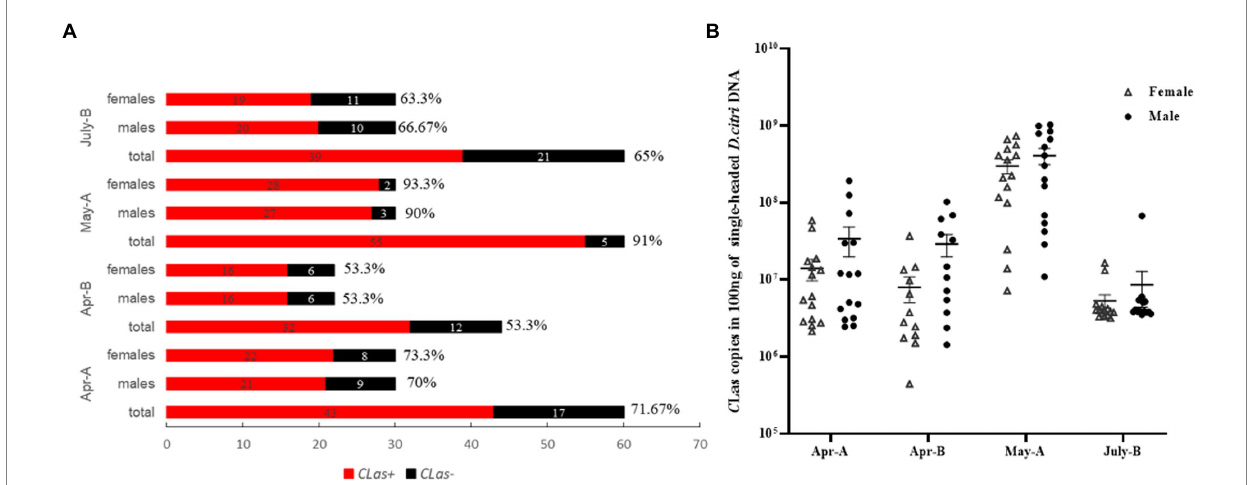
FIGURE 5 Detection of infection rate and titer of C Las in males and females of D. citri in the field. (A) Single male and single female were tested for C Las-infection rate in the field D. citri , and the percentages indicate the C Las-infection rates in each group. (B) C Las titers per 100 ng of DNA in males and females of the C Las-infection D. citri